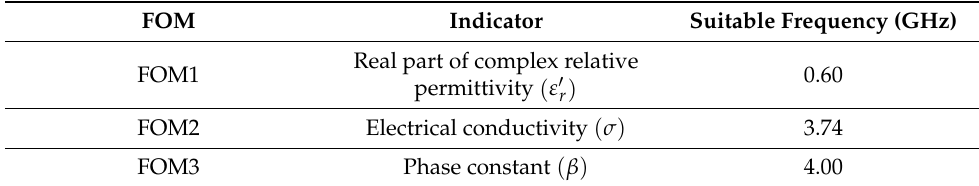
Table 2. Comparison of FOMs in experiments of honey